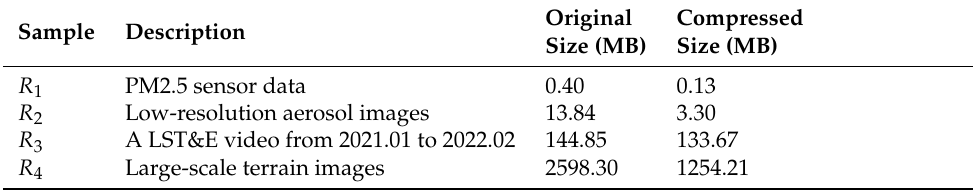
Table 3. Sample description of the used IoT remote sensing data in our experiments.